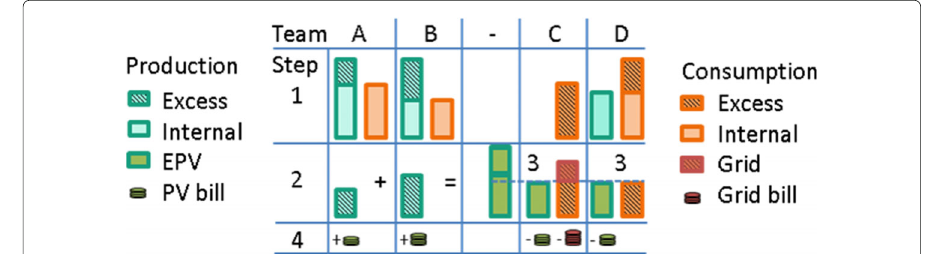
Fig. 1 Publicly known energy distribution and pricing